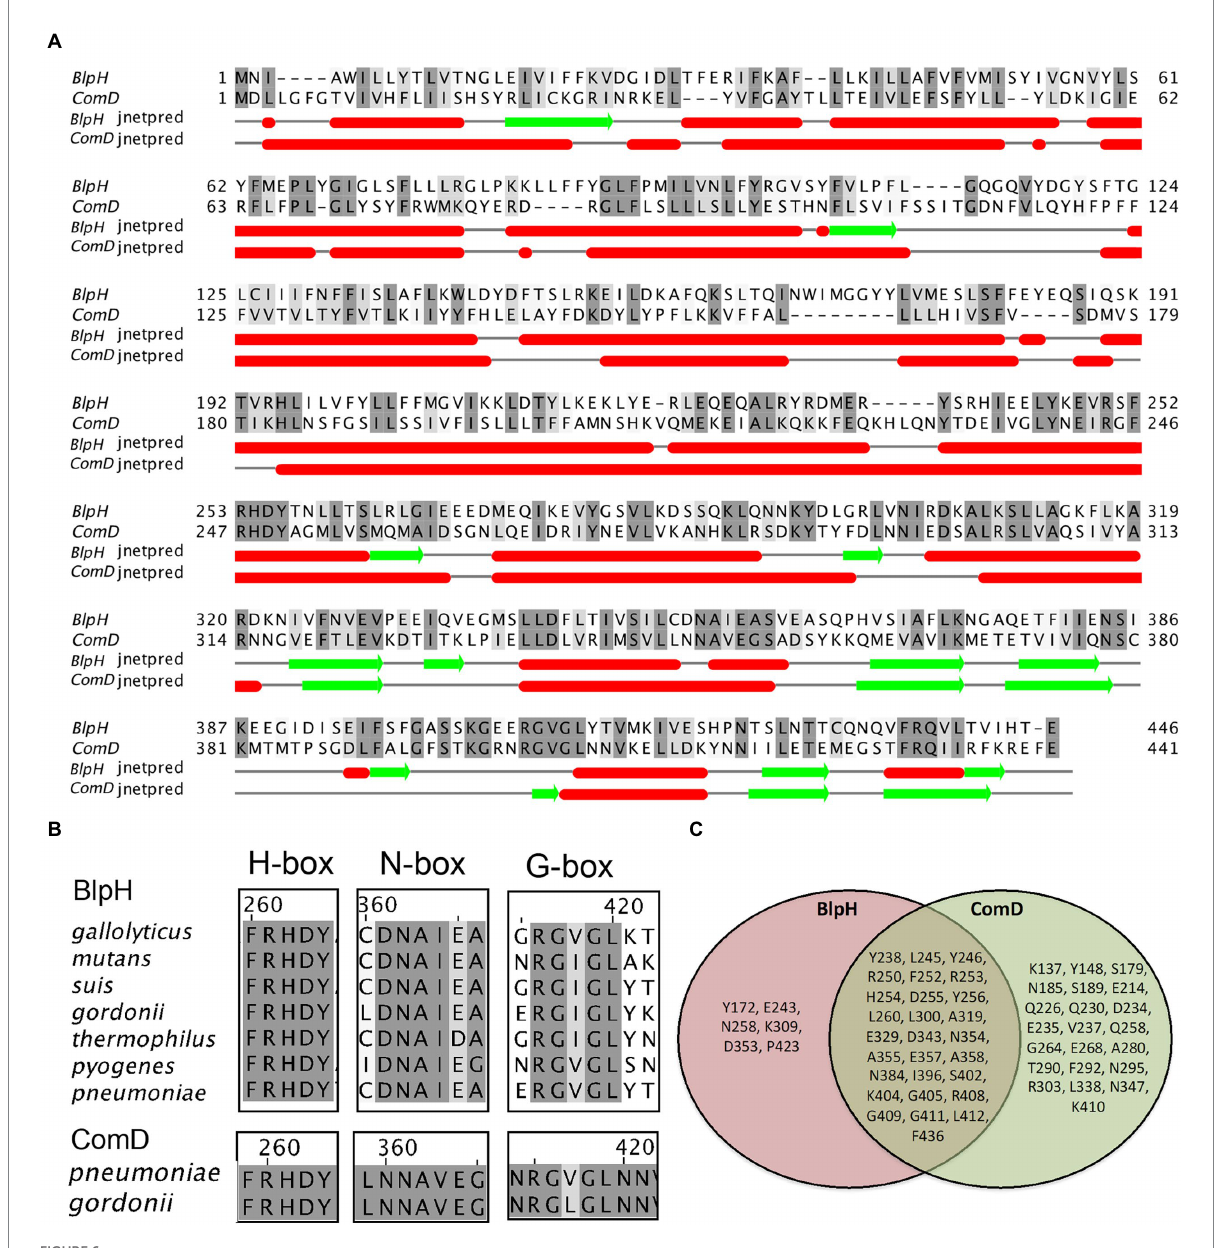
FIGURE 6 Comparison of conserved motifs and secondary structure of BlpH and ComD sensor kinases. (A) The amino acid sequence alignment of BlpH SPN and ComD SPN was performed using Muscle. The residues that showed ≥ 60% conservation were highlighted with grey color. Secondary structures of BlpH and ComD were predicted separately using Jnetpred in Jalliew. Red cylinders and green arrows represent secondary structures of helices and sheets, respectively. (B) Alignment of H-box, N-box, and G-box motifs of BlpH and ComD sensor kinases. The multiple sequence alignment of BlpH homologs from different streptococcal groups was performed as described above. Highly conserved residues in the H-box, N-box, and G-box, which are characteristics of the HPK-10 family, are highlighted in grey. (C) A Venn diagram illustrating the common and non-common conserved residues in BlpH and ComD. The multiple sequence alignment of BlpH and ComD homologs from different streptococcal species was performed as described above. The common conserved residues between BlpH SPN and ComD SPN homologs are mentioned in overlapping circle. The residues that are completely conserved in only BlpH or only ComD homologs are mentioned in separate